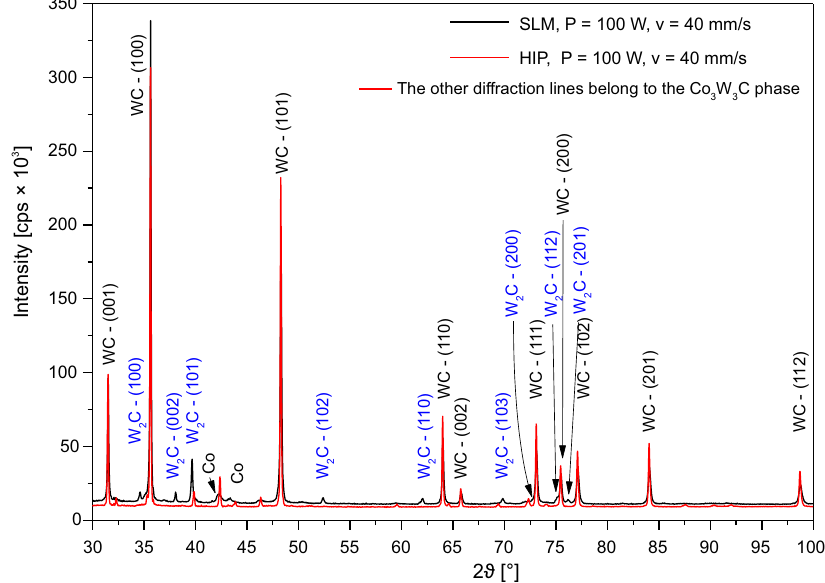
Figure 14. X-ray spectrum indicating the phase composition of specimens manufactured using high levels of